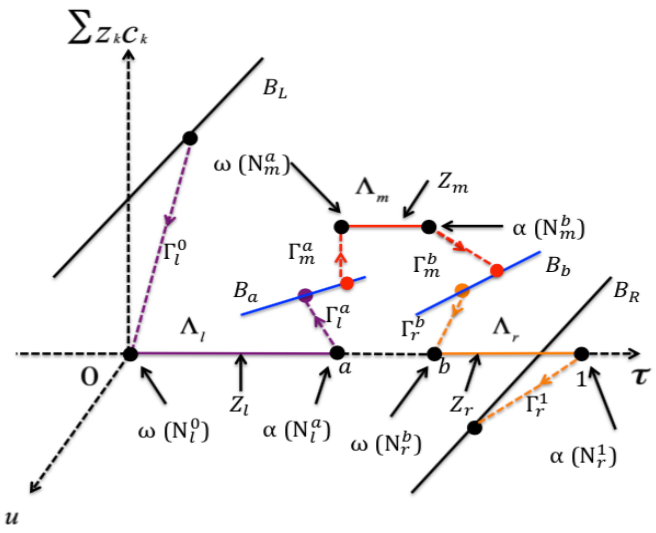
Figure 1. Schematic picture of a singular orbit projected to the space of ( u , ∑ z k c k , τ ) with Q ( x ) defined in